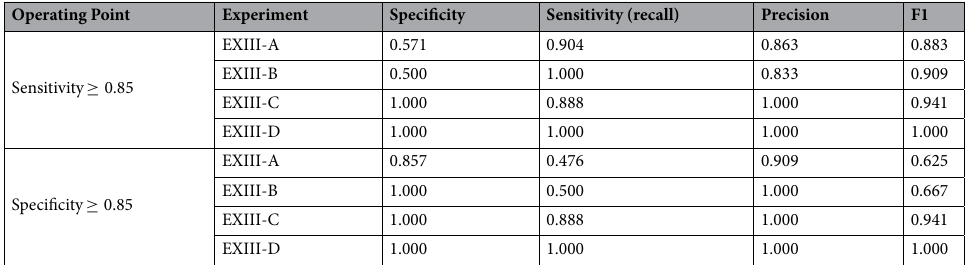
Table 3. Table aggregating the results from the series of experiments under EXIII; essentially, how well the subject-level PtM indicator can be used to discriminate between the PD and HC populations. The obtained results are presented in two operating points, one requiring high sensitivity (upper half) and one requiring high specificity (lower half).